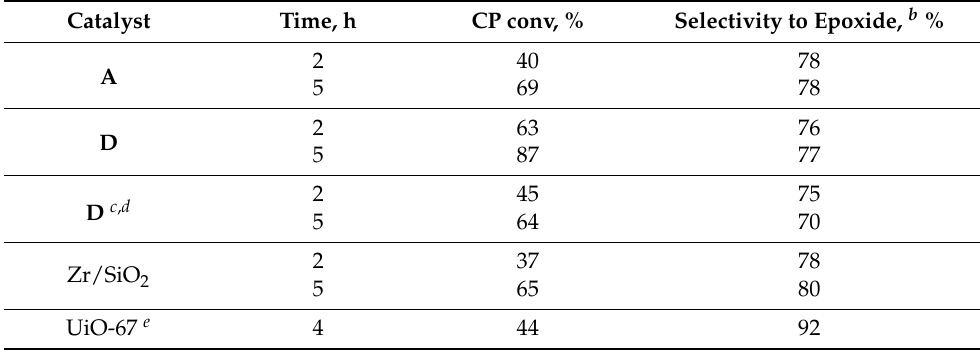
Table 4. Caryophyllene oxidation with H 2 O 2 in the presence of Zr-Si catalysts a . Catalyst Time, h